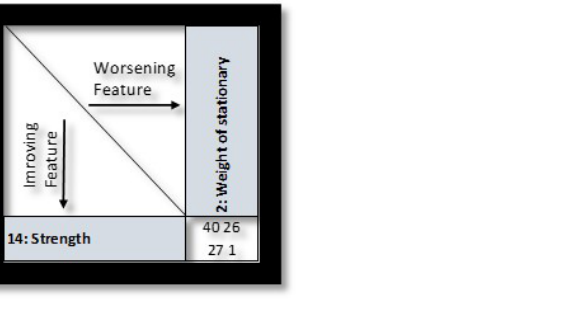
Figure 12. TRIZ contradiction table with options to address technical requirements conflict